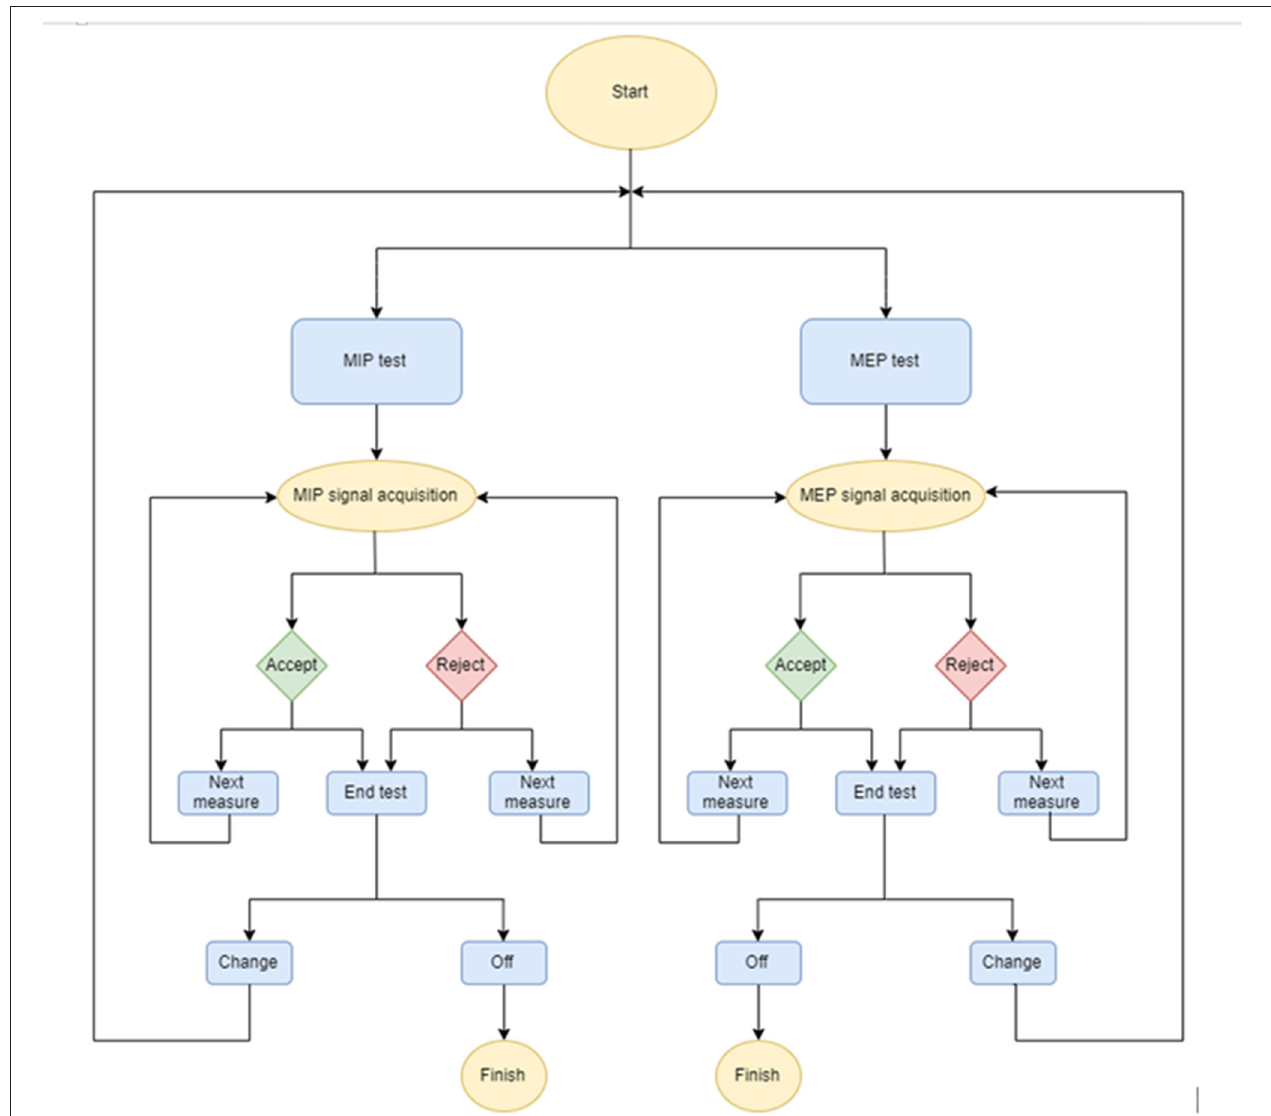
FIGURE 1 | Flow diagram of the maximal inspiratory (MIP) and maximal expiratory (MEP) pressures